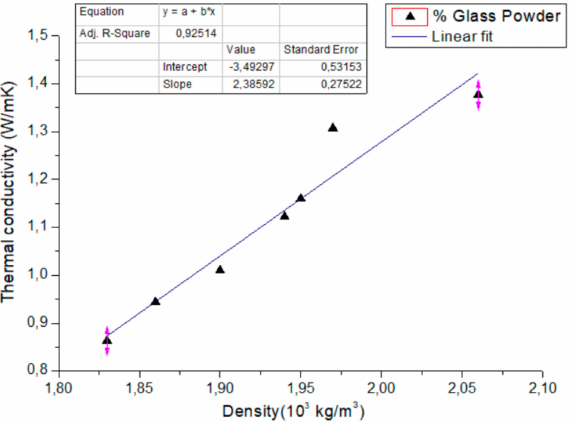
Figure 7. Variation of the thermal conductivity as a function of the bulk density.